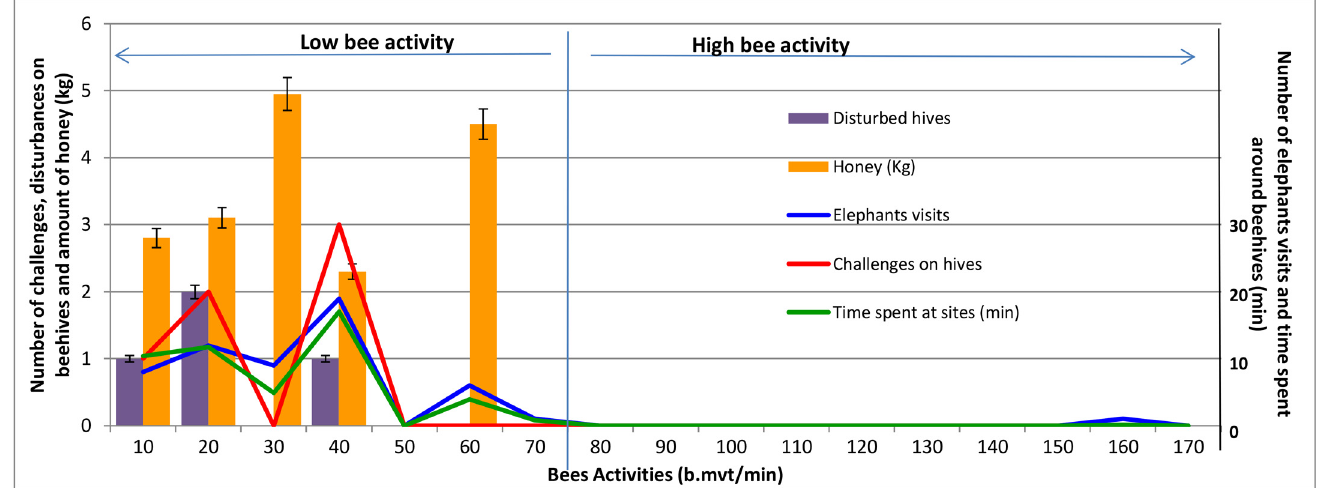
Fig 2. Elephants behavior and honey collected according to bee activity. Bee activity is measured by the number of bees entering and leaving a beehive during one minute (b.mvt/min = number of bee movements per minute). Honey harvested (Honey) was measured in